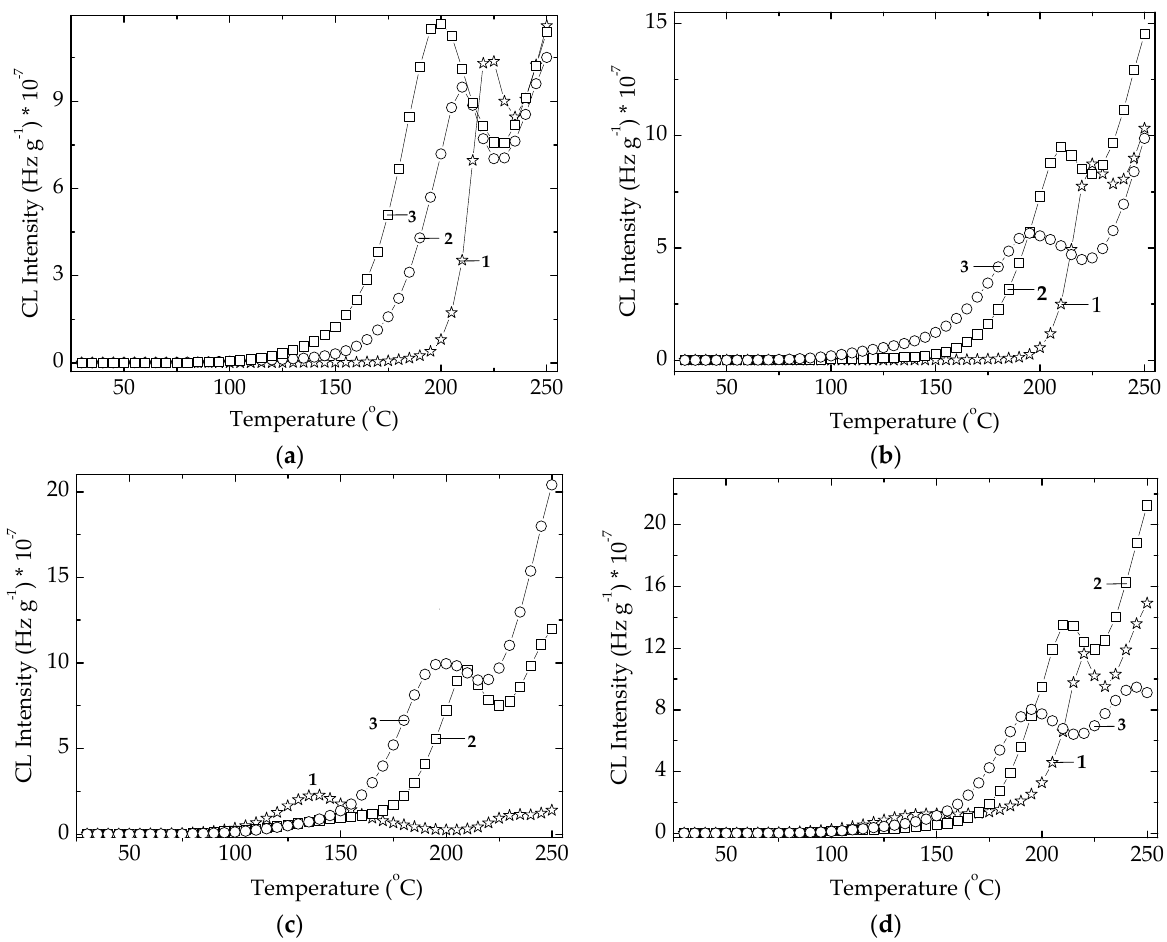
Figure 11. Isothermal spectra record on EPDM hybrids aged by γ -irradiation. ( a ) Control; ( b ) EPDM/Ov-POSS 5; ( c ) EPDM/ Spirulina platensis ; ( d ) EPDM/ Chlorella vulgaris. Doses: (1) 0 kGy; (2) 25 kGy; (3) 100 kGy. Heating rate: 5 °C min − 1 .